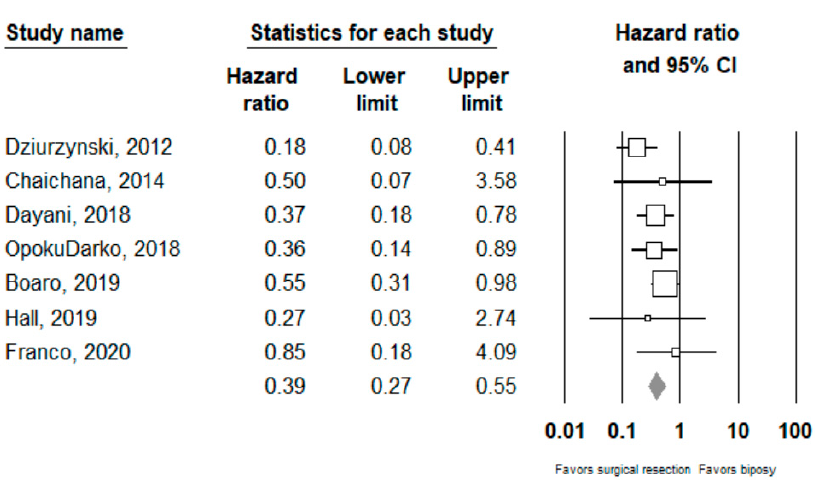
Figure 2. Forest plots showing hazard ratios of surgery vs biopsy for overall survival. Each study is shown by the point estimate of the hazard ratio and 95% confidence intervals (extending lines). The di- amond center represents the estimated pooled hazard ratio and the width represent its 95% confidence interval (labelled